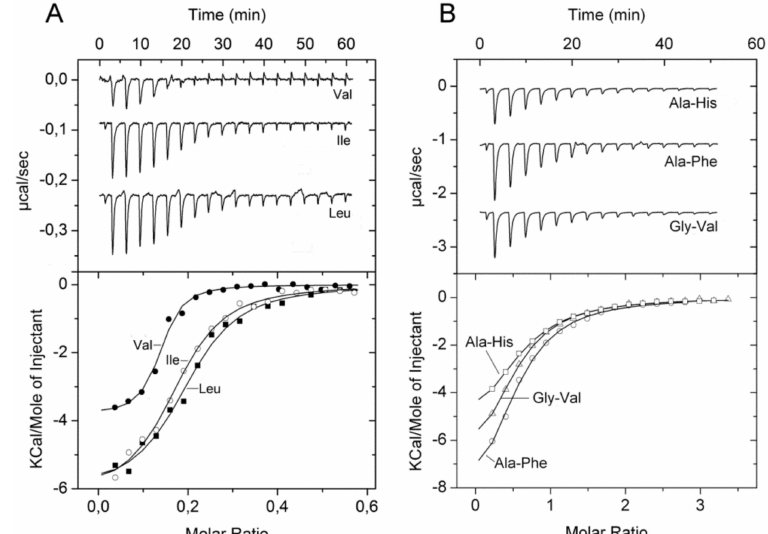
Figure 6. Microcalorimetric binding studies of amino acids and dipeptides to di ff erent solute binding proteins of P. aeruginosa . ( A ) Titration of 10 µ M PA1074 with 100 µ M l -Val, l -Ile and l -Leu (6.4 µ L aliquots). ( B ) Titration of 25 µ M PA4500 with 1 mM solutions of di ff erent dipeptides (6.4 µ L aliquots). Upper panel: Raw titration data. Lower panel: Dilution heat corrected and concentration normalized integrated raw data. The line is the best fit using the ‘One Binding Site’ model of the MicroCal version of